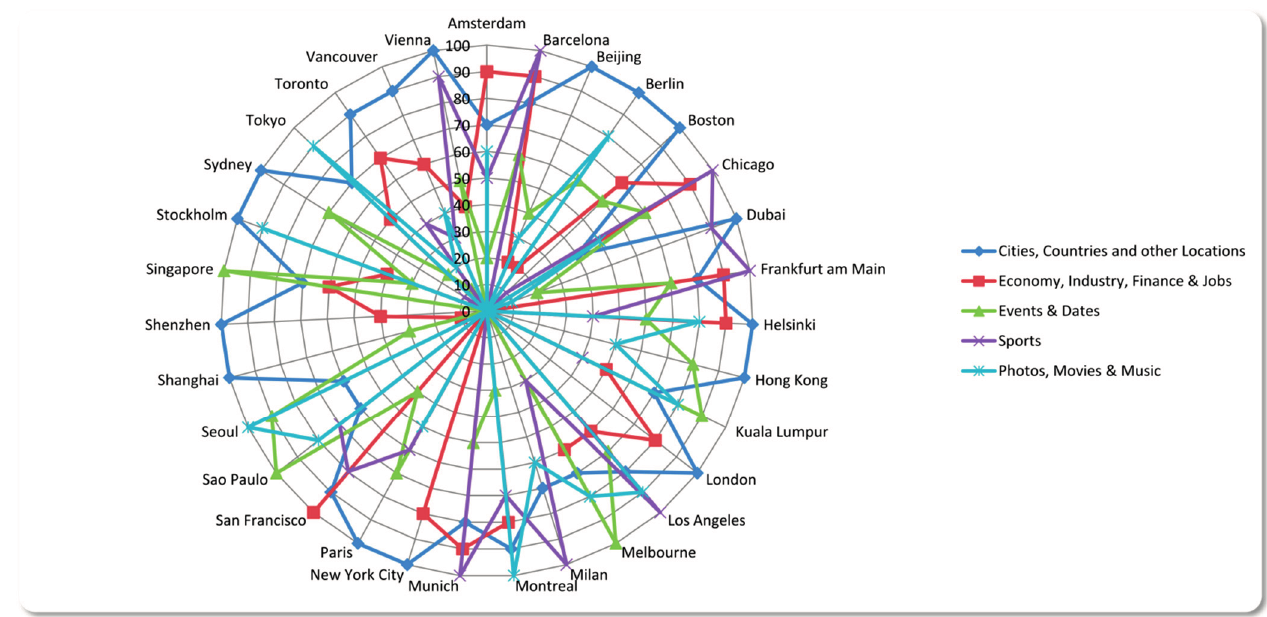
Figure 4. The top five shared services on Twitter.